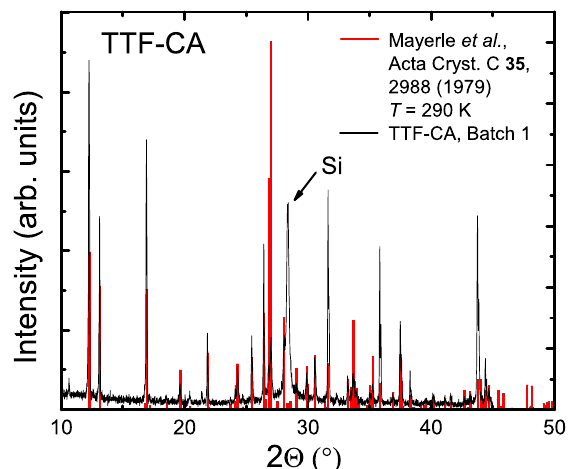
Figure 7. Comparison of the experimental powder diffractogram (black) of TTF-CA (Batch 1) with the simulated diffractogram (red) calculated from the crystal structure Mayerle et al. [3]. The broad maximum at 2 Θ = 28.4 ◦ can be attributed to the silicon